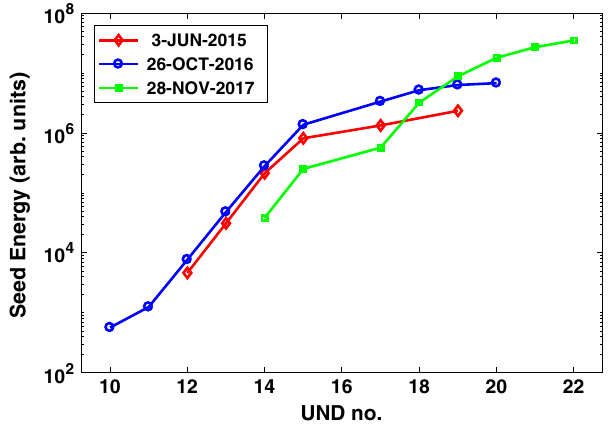
FIG. 3. Strength of the amplified self-seeded spectral line as a function of the last active undulator segment for the three 1-keV experimental shifts. The monochromatized seed is inserted at the entrance to segment U10. The signal level is derived from the post-undulator spectrometer CCD camera image.